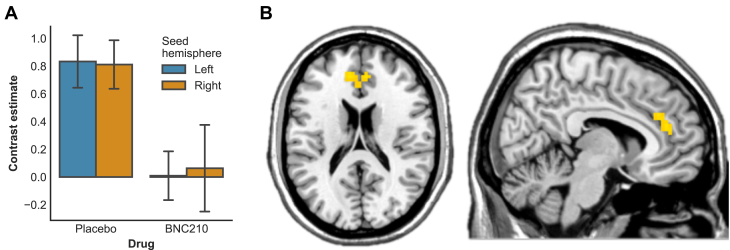
(A) Mean functional connectivity strength with amygdala seeds while viewing fearful faces in the anterior cingulate cortex cluster. (B) Anterior cingulate cortex cluster showing significant reductions in functional connectivity strength with the amygdala under BNC210 (low dose) in the psychophysiological interaction analysis.